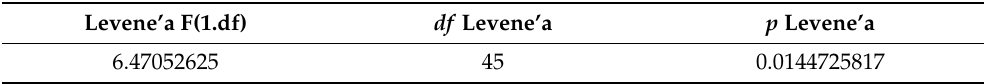
Table 6. Homogeneity of variance test for bending